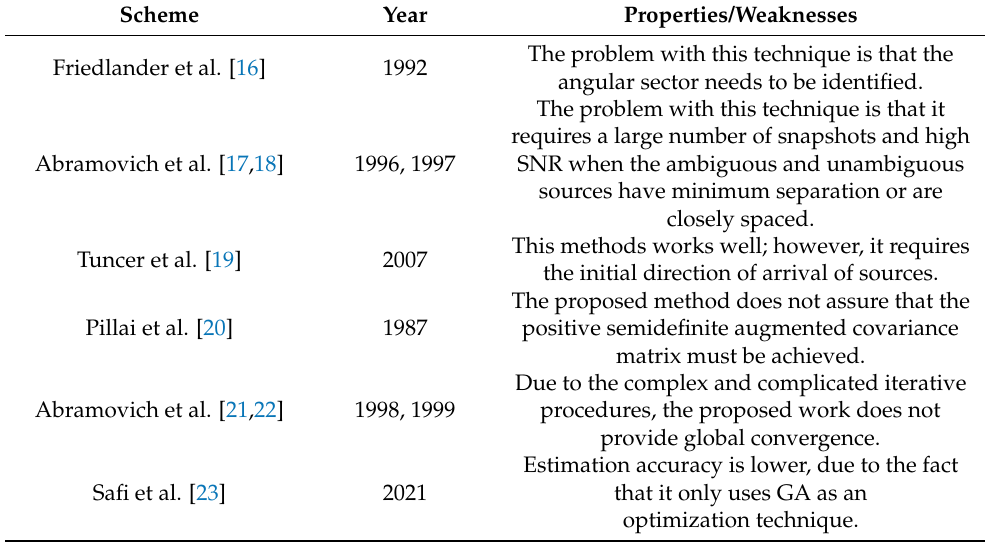
Table 1. Summary of limitations/weaknesses of related